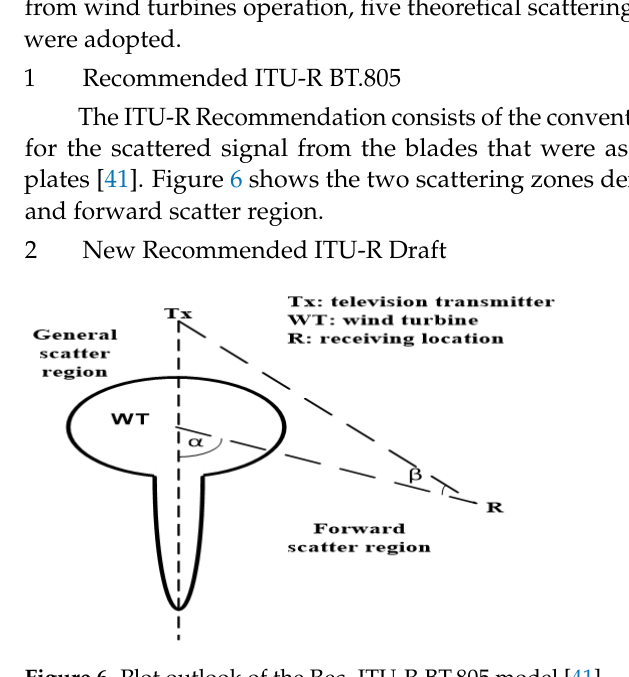
Figure 6. Plot outlook of the Rec. ITU-R BT.805 model [41] .